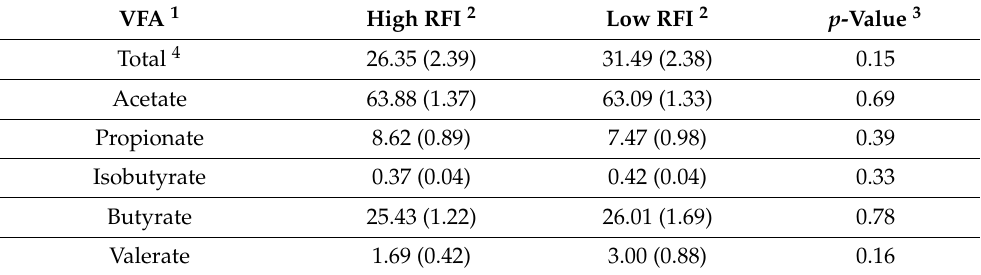
Table 4. Relative proportions of volatile fatty acids by high- and low-residual feed intake (RFI) steers. VFA 1